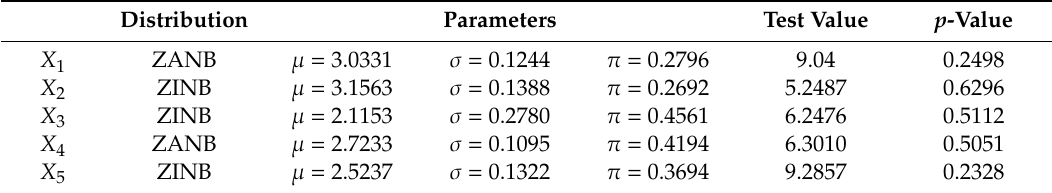
Table 11. Fitting distribution of X 1 , X 2 , X 3 , X 4 , X 5 and goodness of fit test. Distribution Parameters Test Value p -Value X 1 ZANB µ = 3.0331 σ = 0.1244 π = 0.2796 9.04